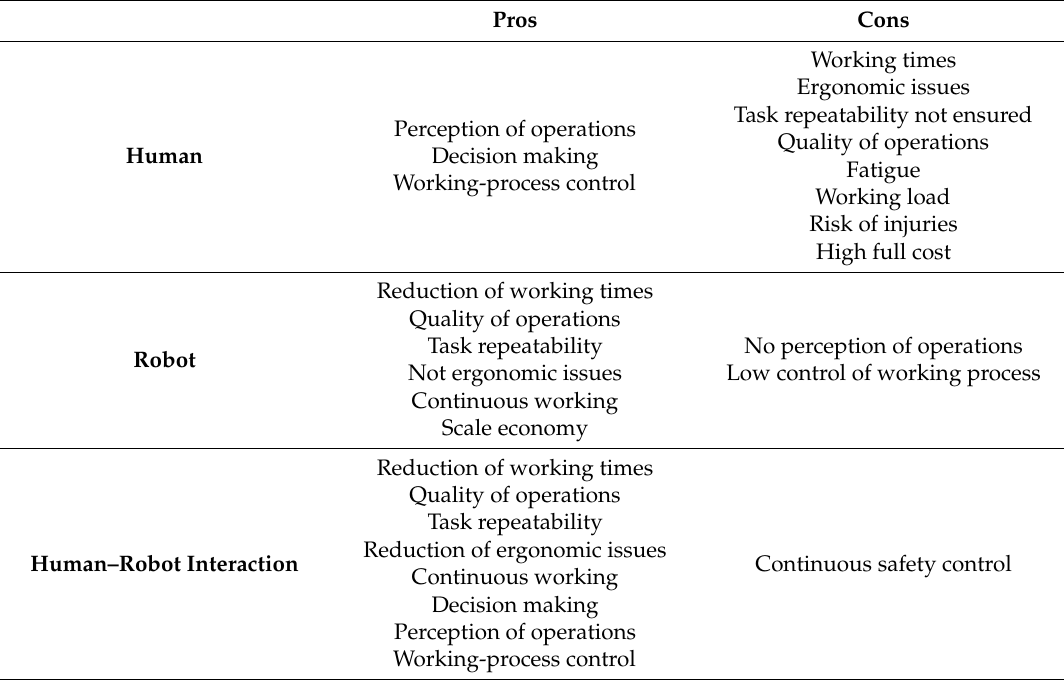
Table 1. Pros and cons of human–robot interaction (HRI).